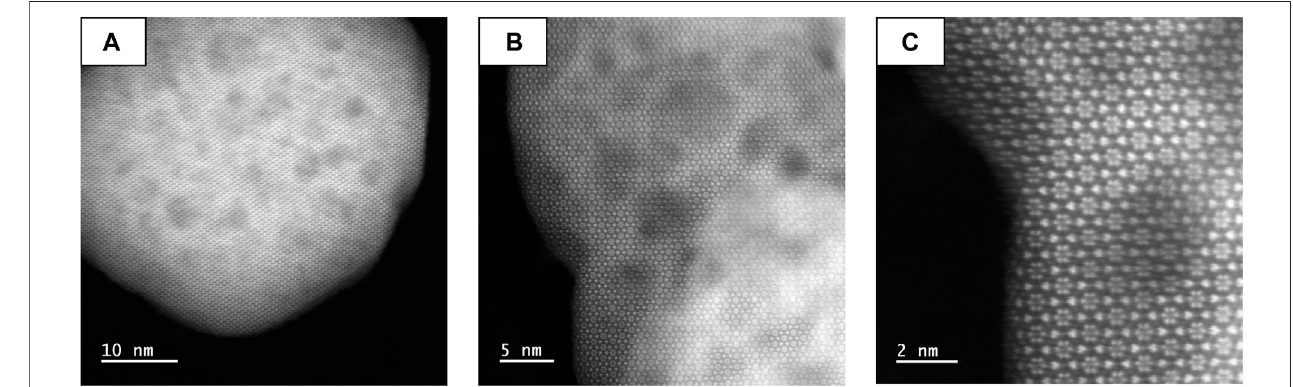
FIGURE 4 | (A) Emission spectra of YAG:Ce nanopowders as a function of the cerium concentration, x. (B) Evolution of the position of the PL peak maximum as a function of the unit cell parameter for the corresponding YAG:Ce nanopowders.